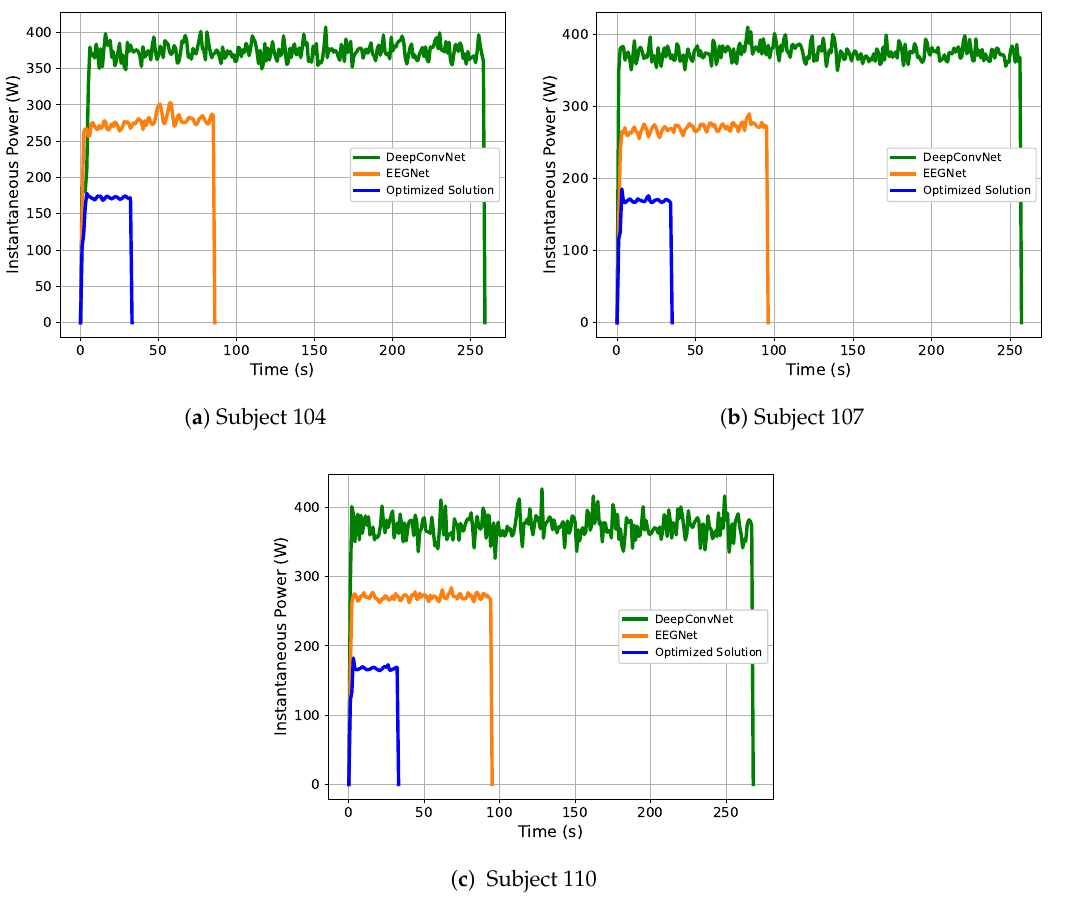
Figure 9. Instantaneous power obtained while training different models and